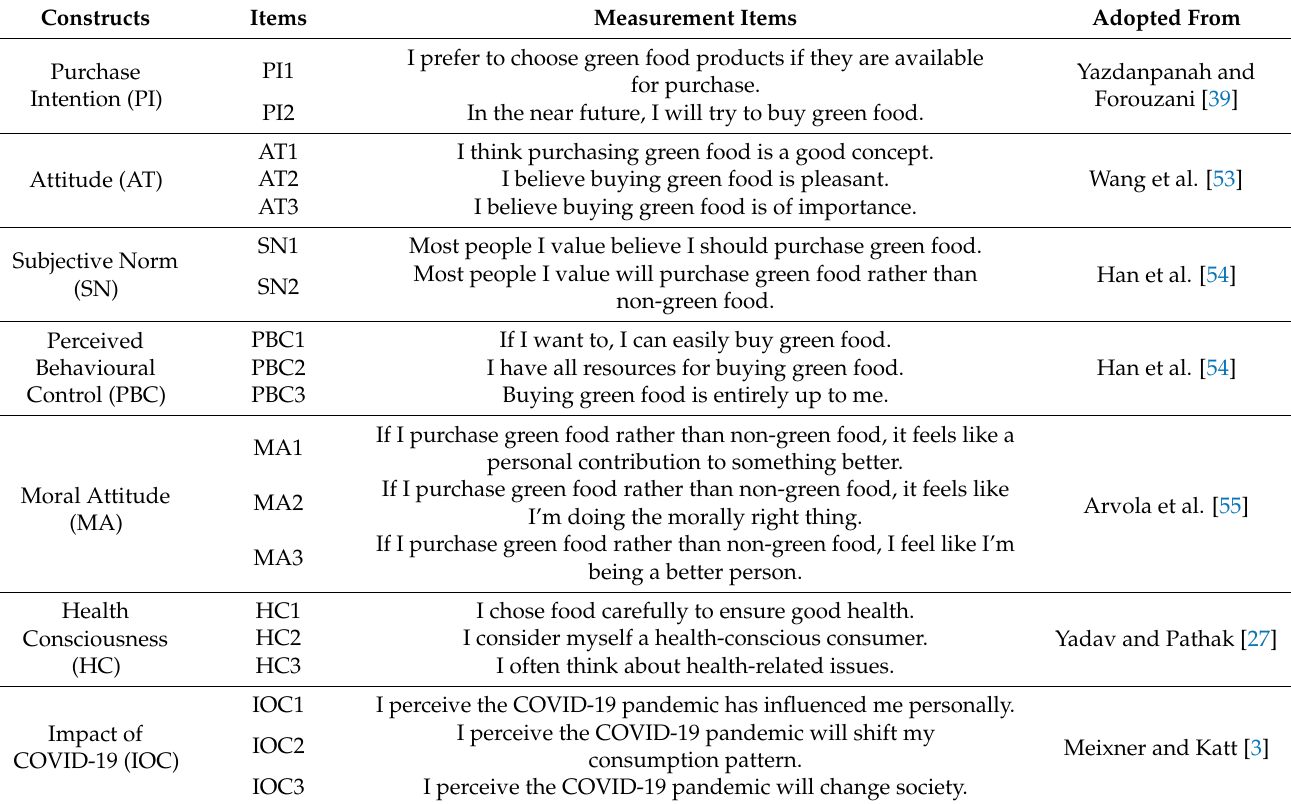
Table 2. Measurement of